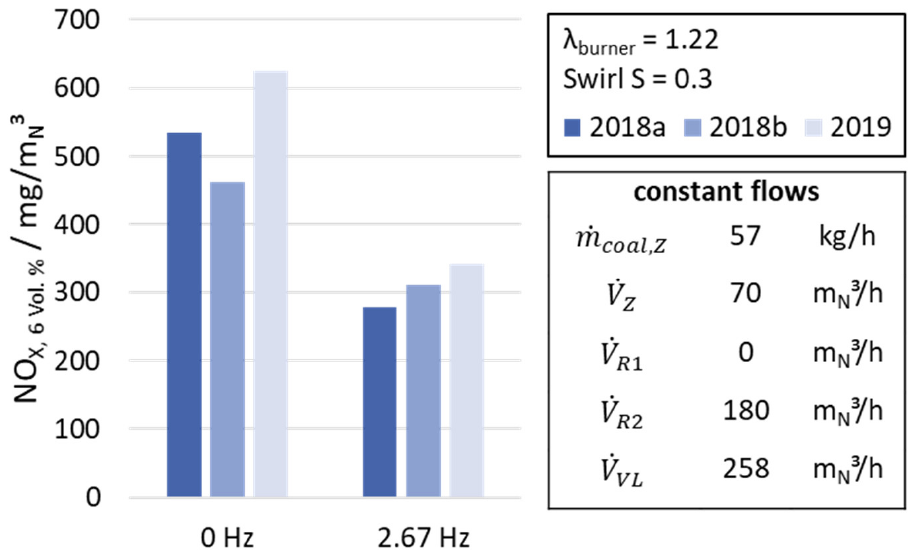
Figure 14. Campaign B reproducibility of test